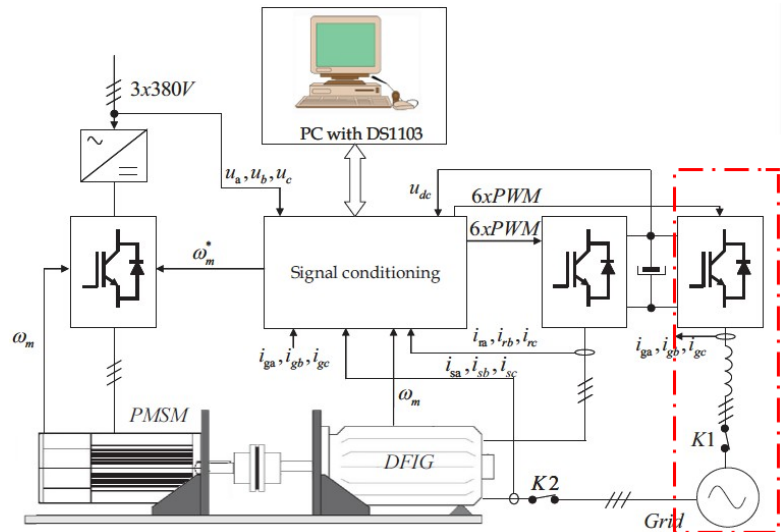
Figure 7. Diagram of the experimental platform for the doubly-fed induction generator (DFIG) [33]; see the text for the squirrel-cage induction generator (SCIG) and PMSG experimental